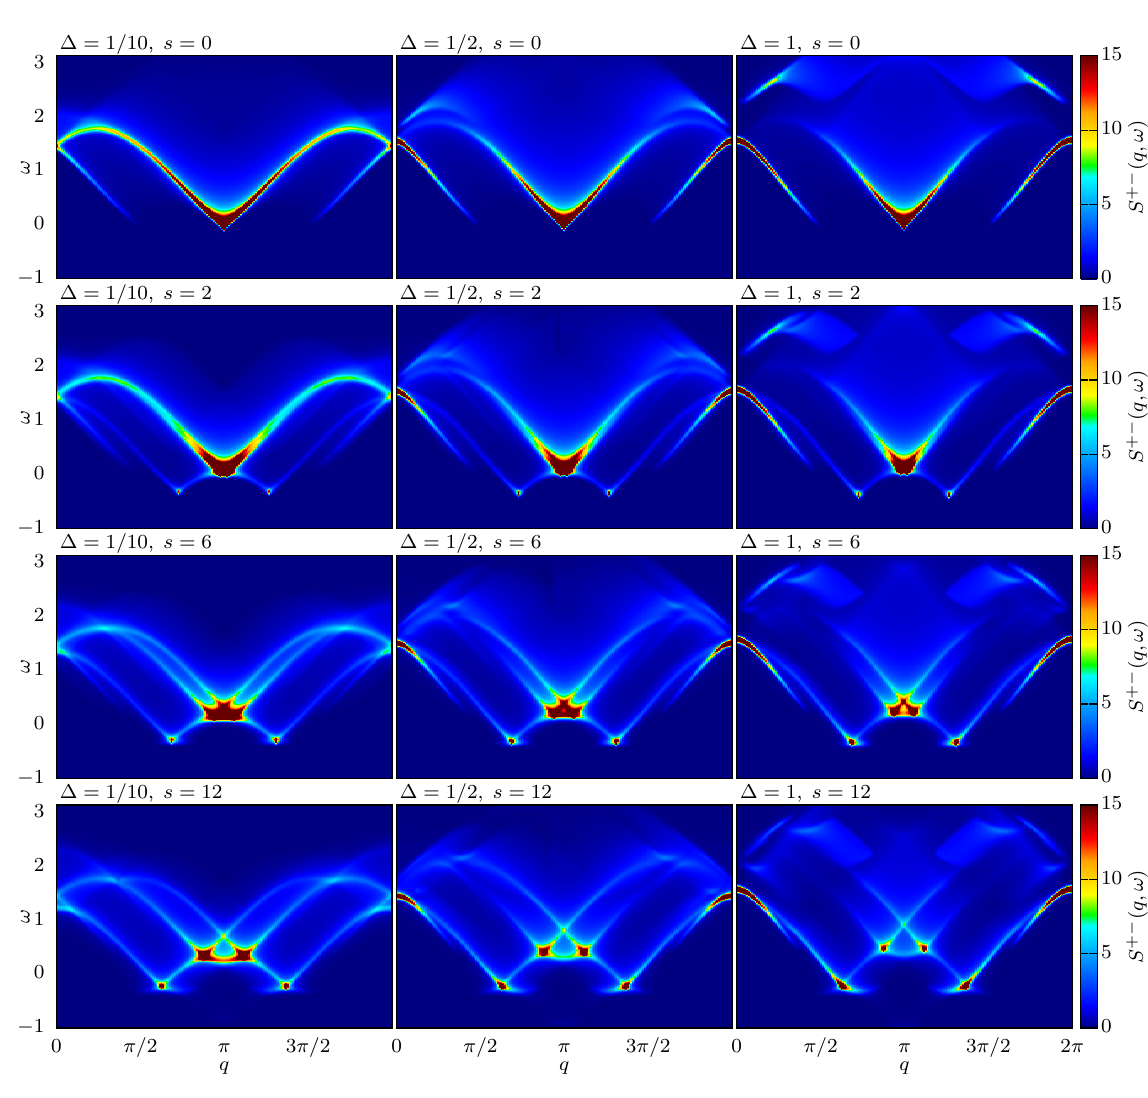
Figure 4: Transverse dynamical structure factor S + − ( q , ω ) at N = 200, M = 50 computed from summations of matrix elements obtained from algebraic Bethe Ansatz, which is furthermore symmetrized around momentum q = π in order to obtain higher sum rule saturations with lower computational time. From left to right, the anisotropies are ∆ = 1 bottom, the momentum shifts in the quantum numbers are s = 0,2,6,12. The corresponding sum rule saturations of the data are listed in Tab. 1, which are substantially lower than the other structure